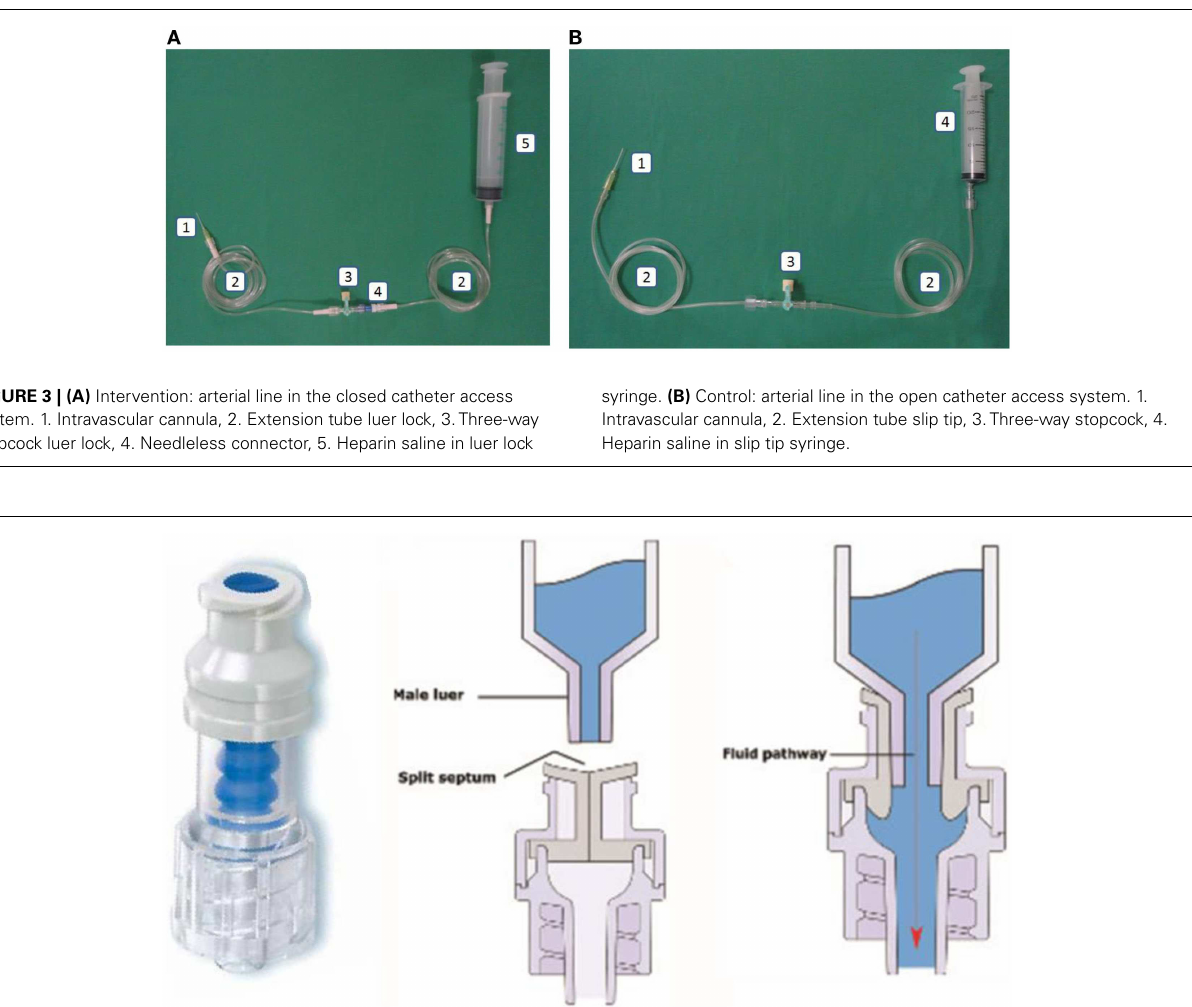
FIGURE 4 | Left: SmartSite® . Center and right: fluid path mechanism